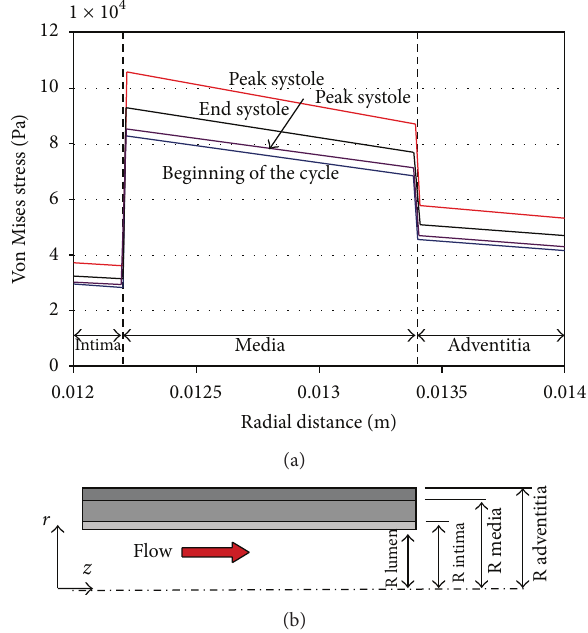
Figure 2: The highest Von Mises stress across the wall of a descending aorta at various periods of the cycle was found at the medial layer as shown in (a) whereas (b) shows the axisymmetric idealized three-layered model of a descending aorta. Adapted from Khanafer and Berguer